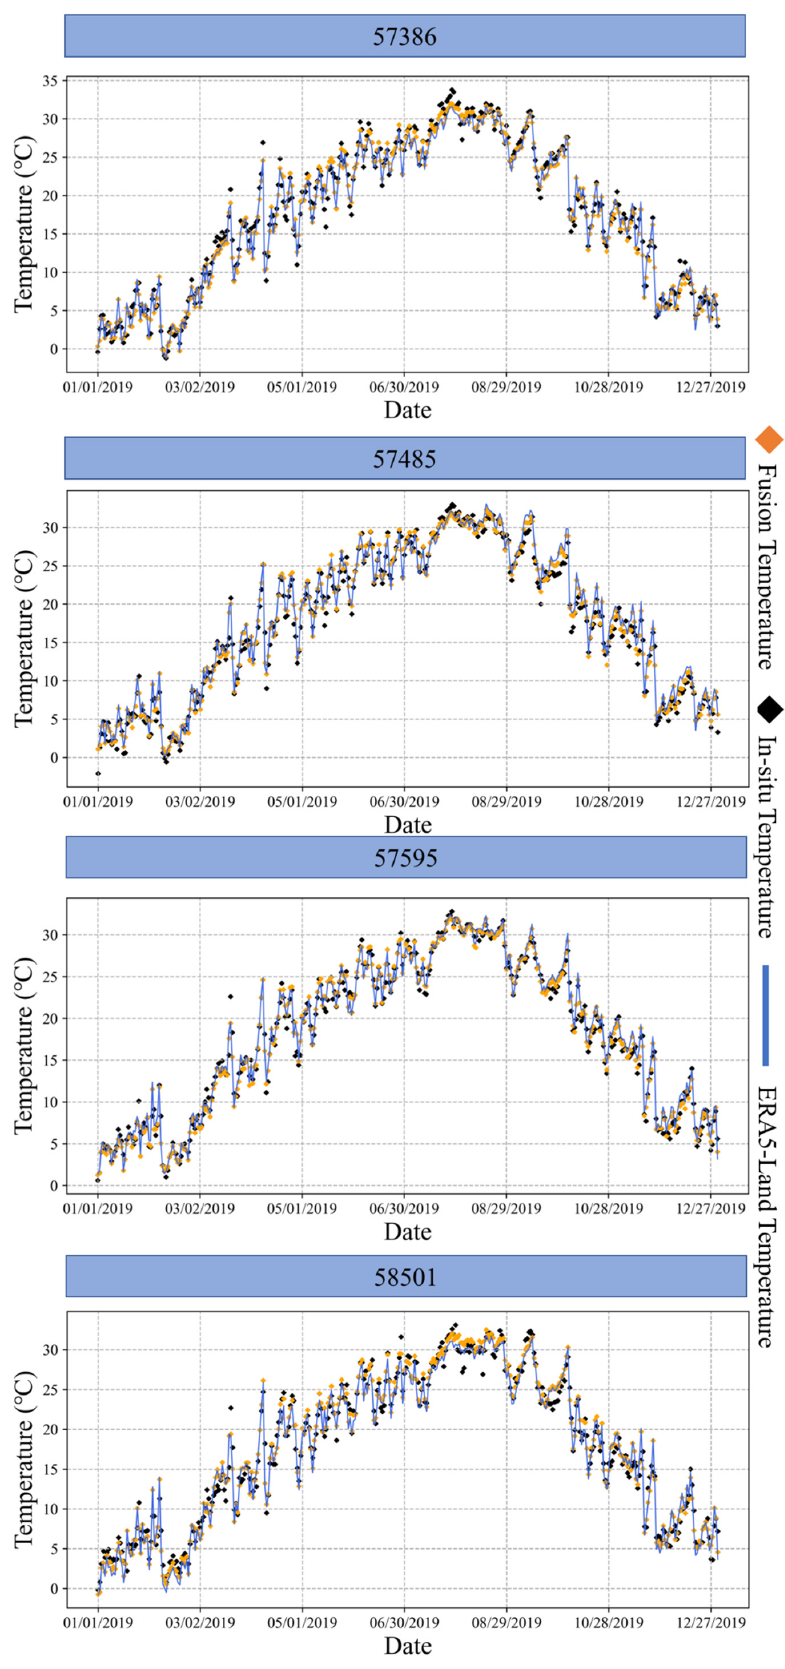
Figure 8. The temporal variations of the temperature data in 2019 at four randomly selected